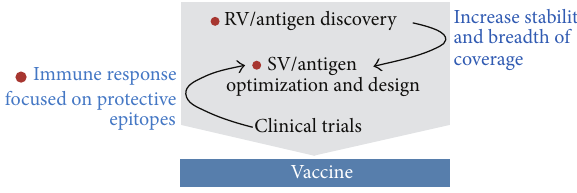
Figure 1: A simplified pipeline for a vaccine development project. Contributions from modern, mainly SV approaches are indicated in blue, while red dots indicate steps aided or made possible by computational